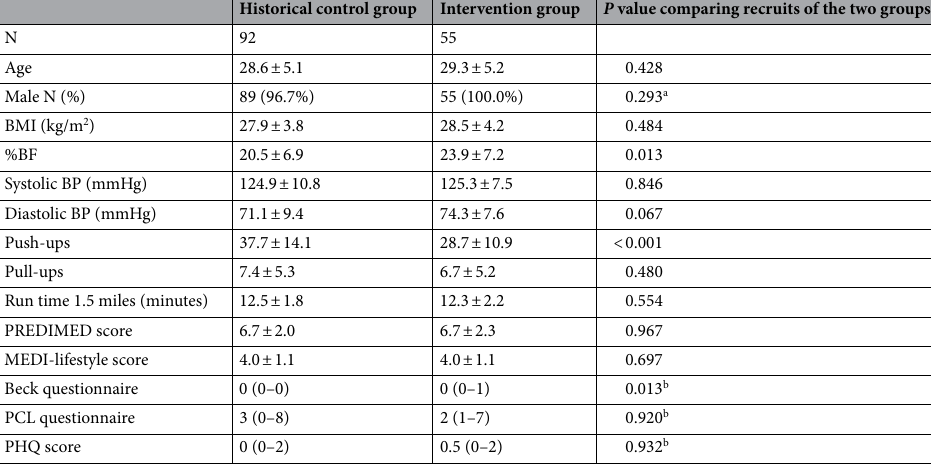
Table 1. Baseline demographics, body composition, physical fitness, and mental health of the recruits of the two groups. Median (Q1–Q3) for Beck questionnaire, PCL questionnaire, and PHQ score. Mean ± SD for other variables except for Male. BMI, %BF, blood pressures, push-ups, pull-ups, run time, and MEDI-lifestyle score are only available for one academy of the intervention group (n = 37). BMI body mass index, %BF percent body fat, BP blood pressure, Beck Beck depression inventory for primary care, PCL post-traumatic stress disorder (PTSD) questionnaire, PHQ patient health questionnaire. a Derived from Fisher’s exact test. b Derived from Wilcoxon rank sum test with continuity